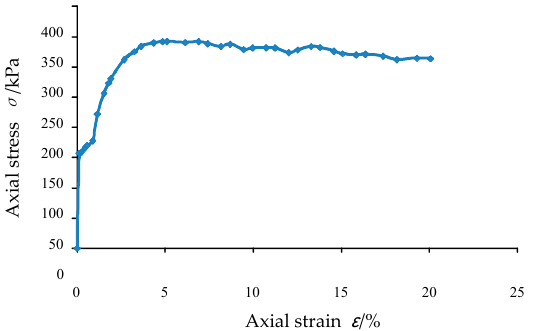
Figure 9. Glass bead specimen in triaxial test.